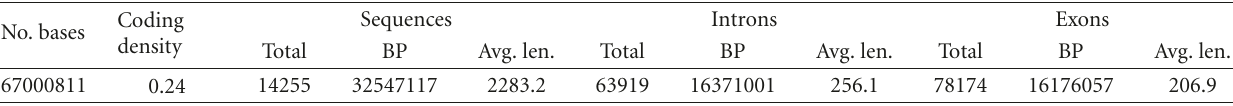
Table 3: Properties of dataset C. elegans , chromosomes I–V